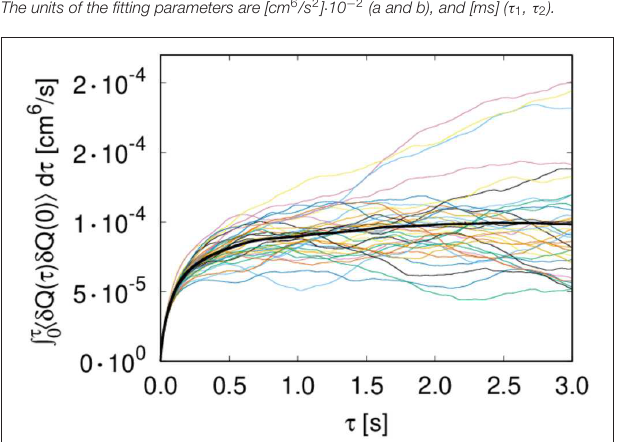
FIGURE 8 | Convergence of the integrated time correlation function [case (A), γ = 30 mN/m and 30 × 20 links]. The colored lines represent individual trajectories; the thicker black line is the average of all